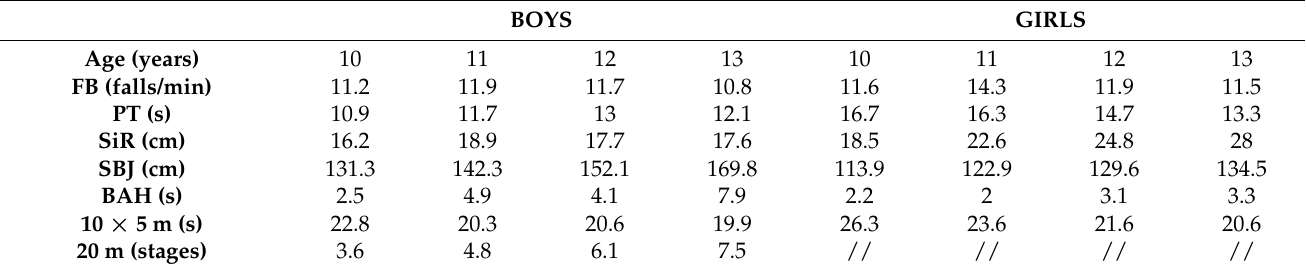
Table 5. The 50th percentile of the physical fitness test stratified by age and sex (boys and girls). BOYS